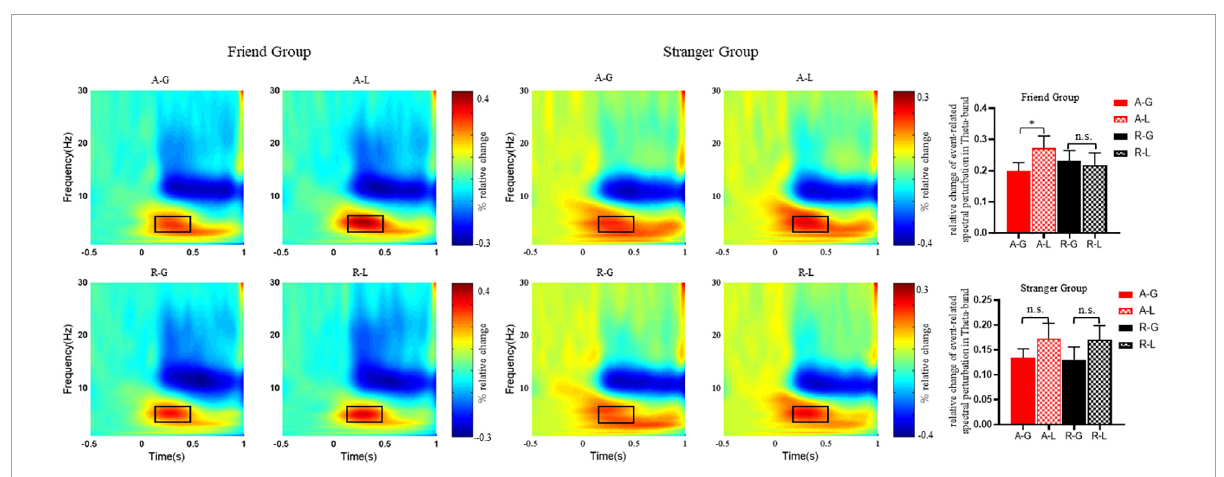
FIGURE4 Grand-averaged time-frequency plots at electrode Fz in response to four combinations of outcome feedbacks following the advisee’s decisions: acceptance and receiving a gain (A-G), acceptance and receiving a loss (A-L), rejection and receiving a gain (R-G), and rejection and receiving a loss (R-L) in the friend group and the stranger group, respectively. Black squares indicate time-frequency windows for significant clusters found in the observed data (theta: 0.2–0.5 s at 4–7 Hz). ∗ p < 0.05, n.s. = non-significant.